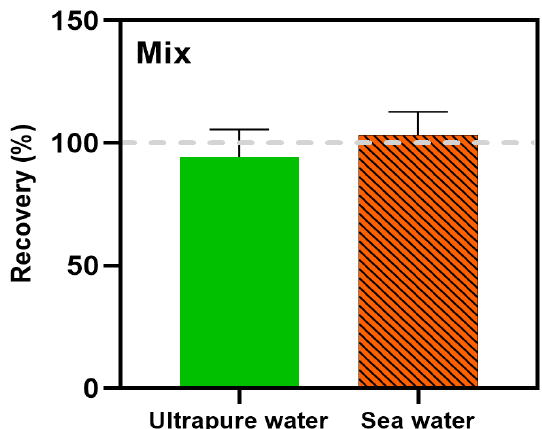
Figure 8. Recoveries (%) of stained MPs counted by flow cytometry after pre-concentration processes of 5 L ultrapure water and sea water samples spiked with a mixture (1:1:1) of PS, LDPE and PP (4000 particles per sample, equivalent to 800 particles L − 1 ). Each bar and error bar represent mean percentages ( n = 9) and relative standard deviations, respectively. The dashed line represents 100% recovery.